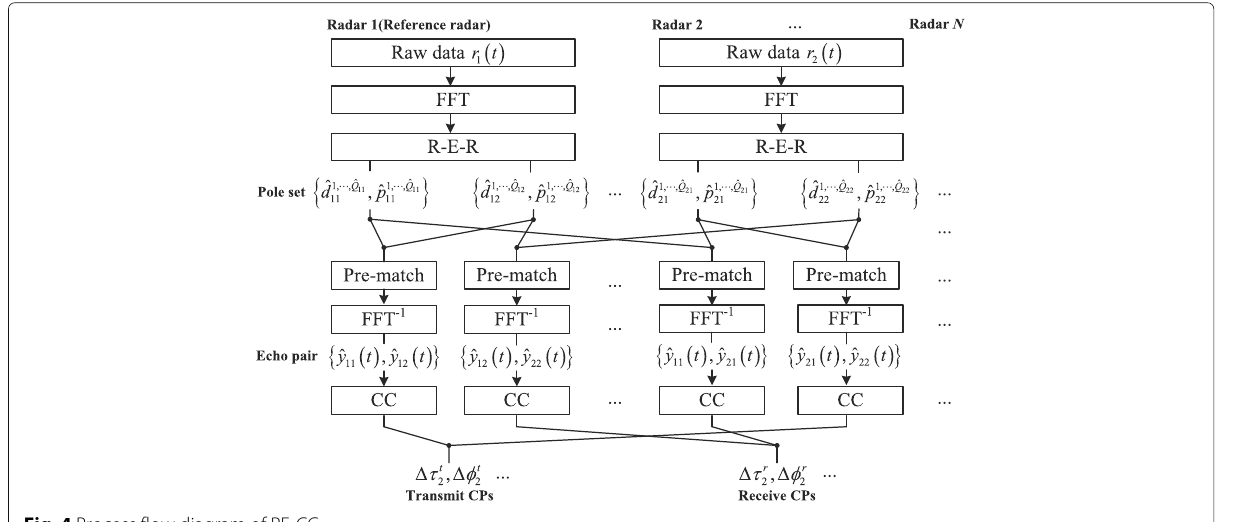
Fig. 4 Process flow diagram of